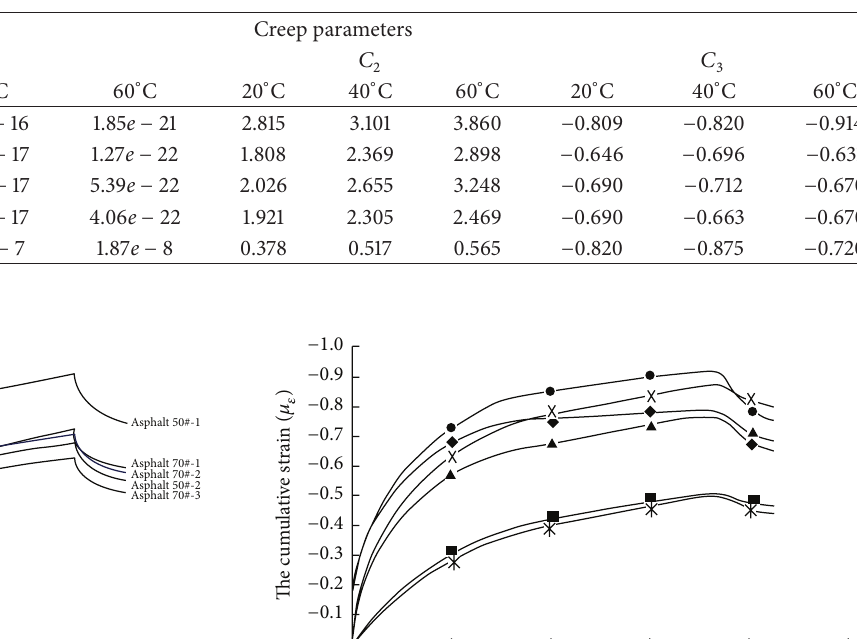
Table 3: Creep parameters for asphalt concrete.